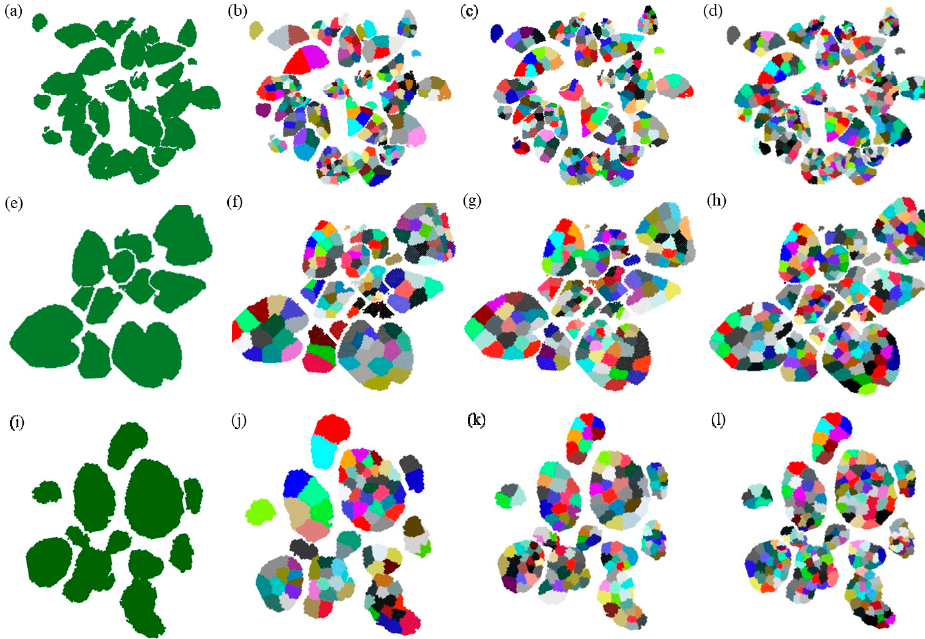
Figure 5. The facet over-segmentation of Epipremnum aureum, Monstera deliciosa, and Calathea makoyana ; point clouds ( a , e , i ) show the top-views of the original three point clouds, respectively; ( b ) the over-segmentation result of Epipremnum aureum when K is 100 and r 1 is 0.05 m; ( c ) the result when K is 40 and r 1 is 0.05 m; ( d ) the result when K is 20 and r 1 is 0.03 m. ( f ) The over-segmentation result of Monstera deliciosa when the value of K is 100 and r 1 is 0.05 m; ( g ) the result when K is 40 and r 1 is 0.05 m; and, ( h ) the result obtained when K is 40 and r 1 is 0.03 m. ( j ) The over-segmentation result of Calathea makoyana when the value of K is 100 and r 1 is 0.05 m; ( k ) the result when K is 40 and r 1 is 0.05 m; and, ( l ) the result obtained when K is 40 and r 1 is 0.03 m.